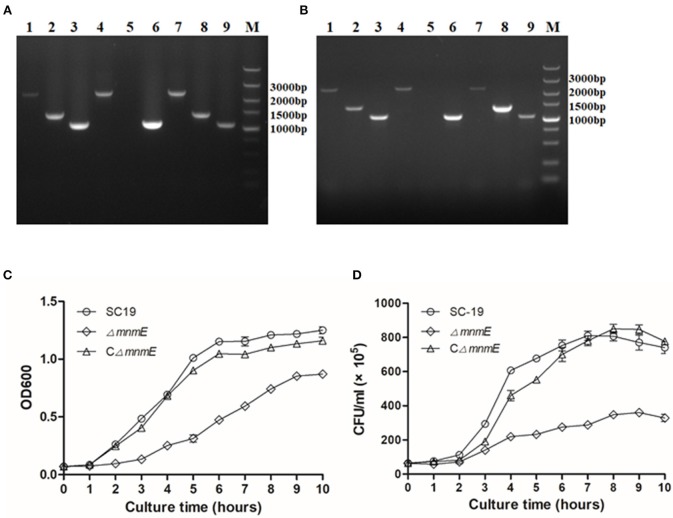
Confirmation and Characterization of the isogenic mutant ΔmnmE. (A) Combined PCR analyses of the ΔmnmE mutant. Lanes 1 to 3 represent the amplification of the upstream gene, mnmE gene, and downstream gene of SC19 using the primer set mnmE-F/mnmE-R, 1453-F/1453-R, and 1455-F/1455-R. Lanes 4 to 6 represent the amplification of the upstream gene, mnmE gene and downstream gene of ΔmnmE using the primer set mnmE-F/mnmE-R, 1453-F/1453-R, and 1455-F/1455-R. Lanes 7 to 9 represent the amplification of the upstream gene, mnmE gene and downstream gene of CΔmnmE using the primer set mnmE-F/mnmE-R, 1453-F/1453-R, and 1455-F/1455-R. (B) Confirmation of the ΔmnmE mutant by RT-PCR. Lanes 1, 4, and 7 represent the amplification of upstream gene of mnmE using the primer set 1453-F/1453-R. Lanes 2, 5, and 8 represent the amplification of mnmE using primer set mnmE-F/mnmE-R. Lanes 3, 6, and 9 represent the amplification of downstream gene of mnmE using the primer set 1455-F/1455-R. Lanes 1, 2, and 3 use cDNA of SC19 as templates, whereas Lanes 4, 5, and 6 use cDNA of ΔmnmE as templates, Lanes 7, 8, and 9 use cDNA of CΔmnmE as templates. (C) Growth curves of the strains. Bacterial cell density was measured spectrometrically at 600 nm. Data were collected at the indicated times. (D) CFU count of the strains. Separate aliquots of the bacterial suspensions were serially diluted and plated to determine CFU numbers per milliliter. Data were collected at the indicated times.